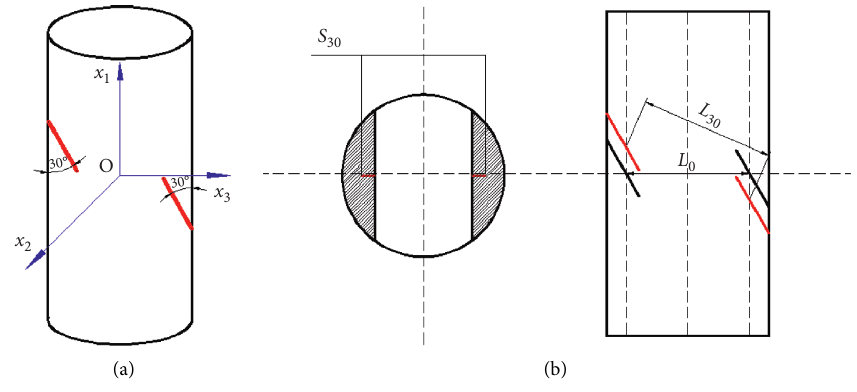
Figure 8: Coordinate axis of jointed rock